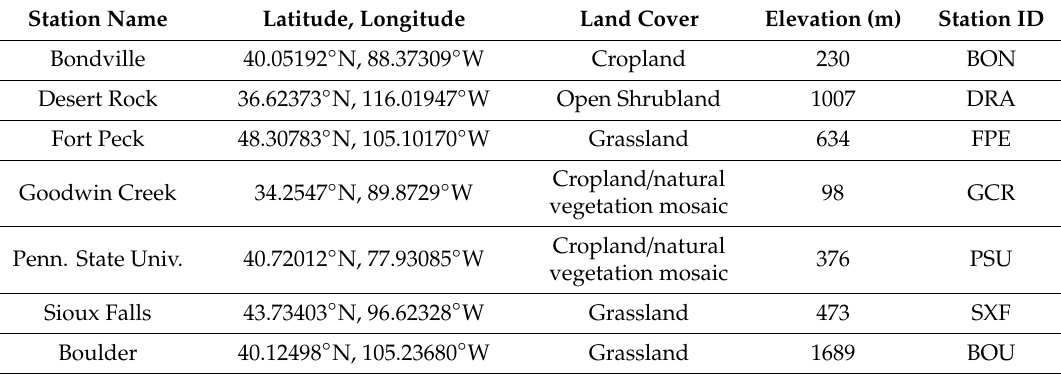
Table 2. Validation sites of